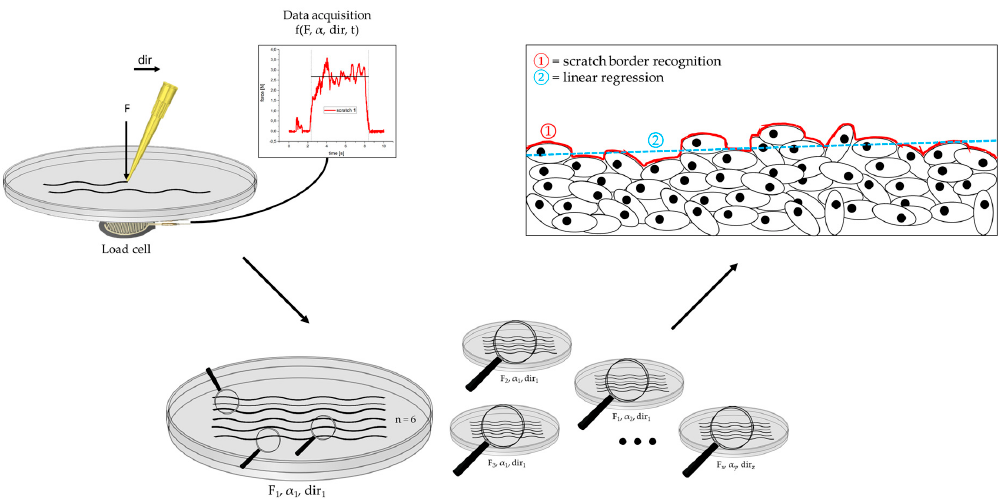
Figure 1. Scheme of the data acquisition. In the first step, acting forces are collected in a variety of experimental configurations. Secondly, each scratching setup (F, α , dir) is evaluated microscopically in a sixfold determination. Finally, the obtained pictures are processed concerning the scratch border recognition and subsequent regression for roughness quantification.